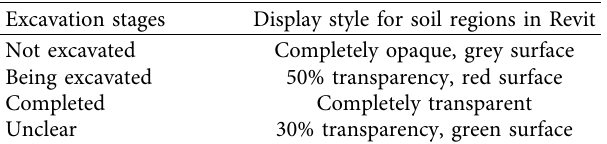
Figure 2: User interface of the developed software based on Autodesk Revit. Table 2: Displayed styles for soil regions in different excavation